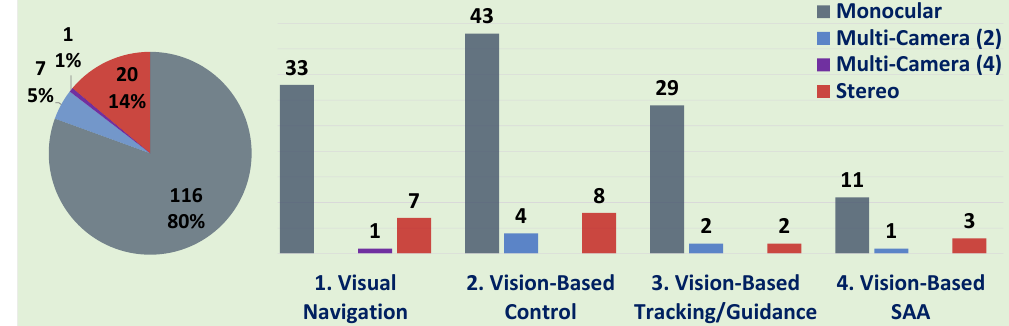
Figure 14. Vision system class distribution over the database.